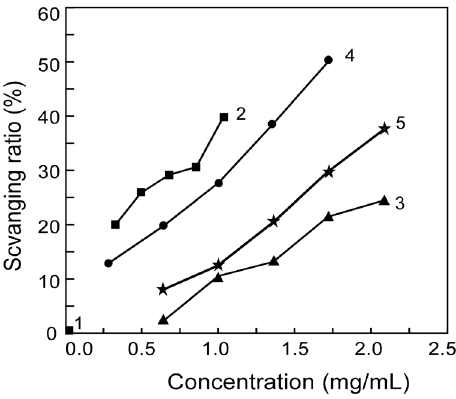
Fig. 5. · O − scavenging capacity: 1 - blank solution; 2 - benzoic 2 acid; 3 - Vc; 4 - mannitol; 5 -